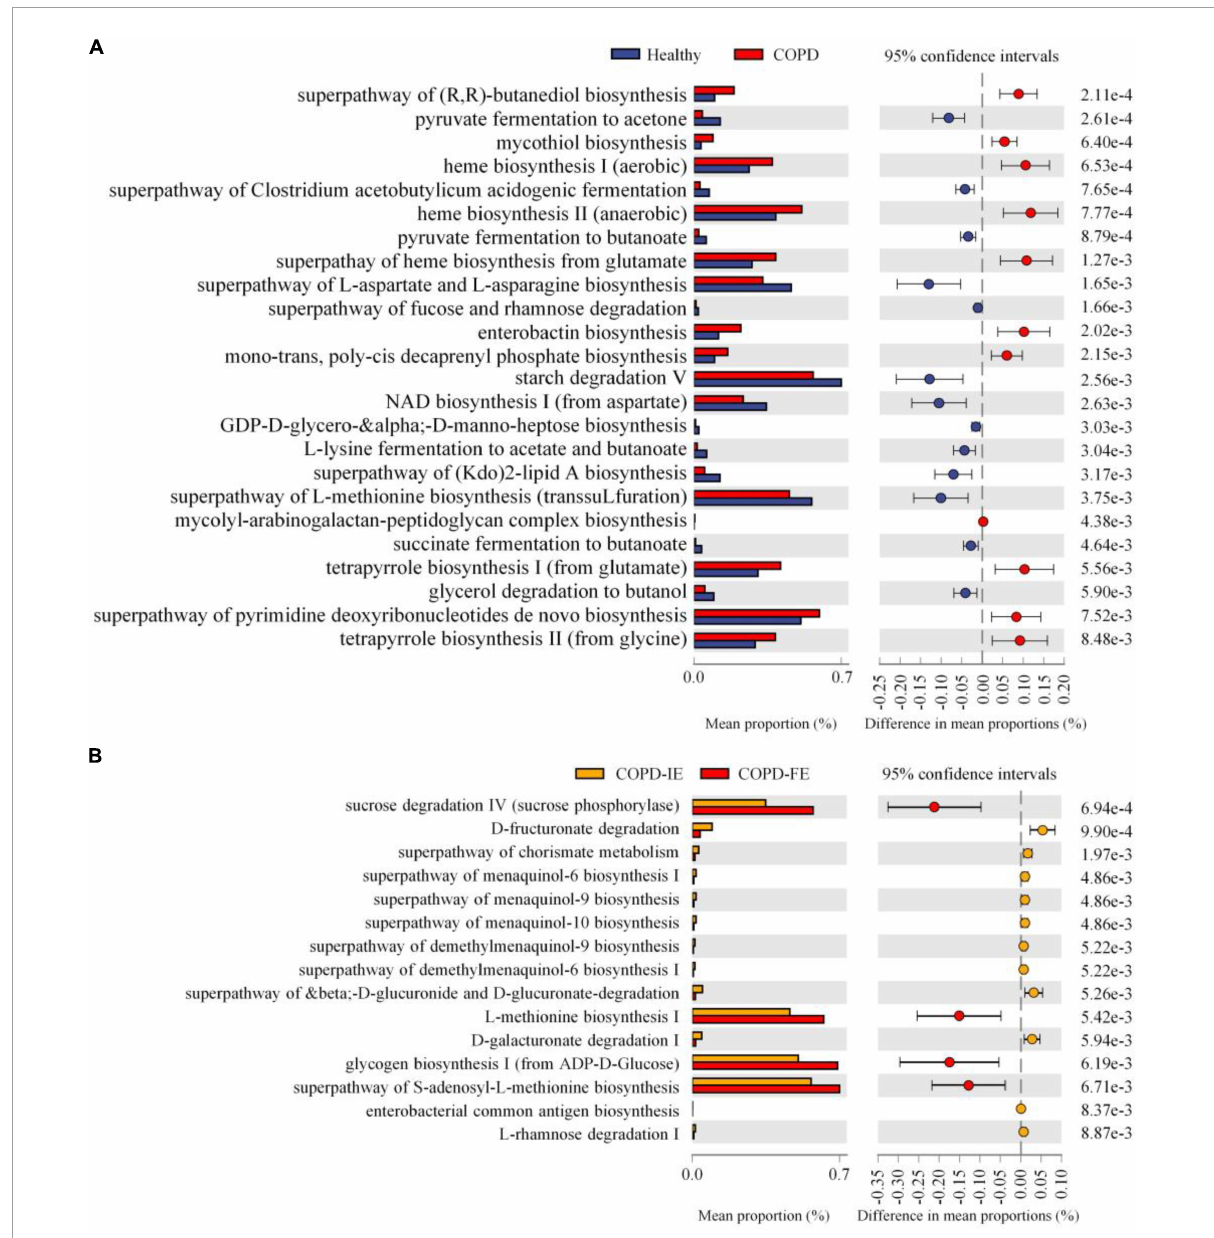
FIGURE7 Function prediction of sputum microbiome by PICRUSt2. Based on predicted EC numbers and pathways, (A) 11 predicted microbial functions were remarkably increased, while 13 functions were remarkably decreased in chronic obstructive pulmonary disease (COPD) compared with healthy controls. (B) Four predicted microbial functions were remarkably increased, while 11 functions were remarkably decreased in COPD with frequent exacerbations (COPD-FE) compared with COPD with infrequent exacerbations (COPD-IE). [Welch’s t -test (two-sided): p <